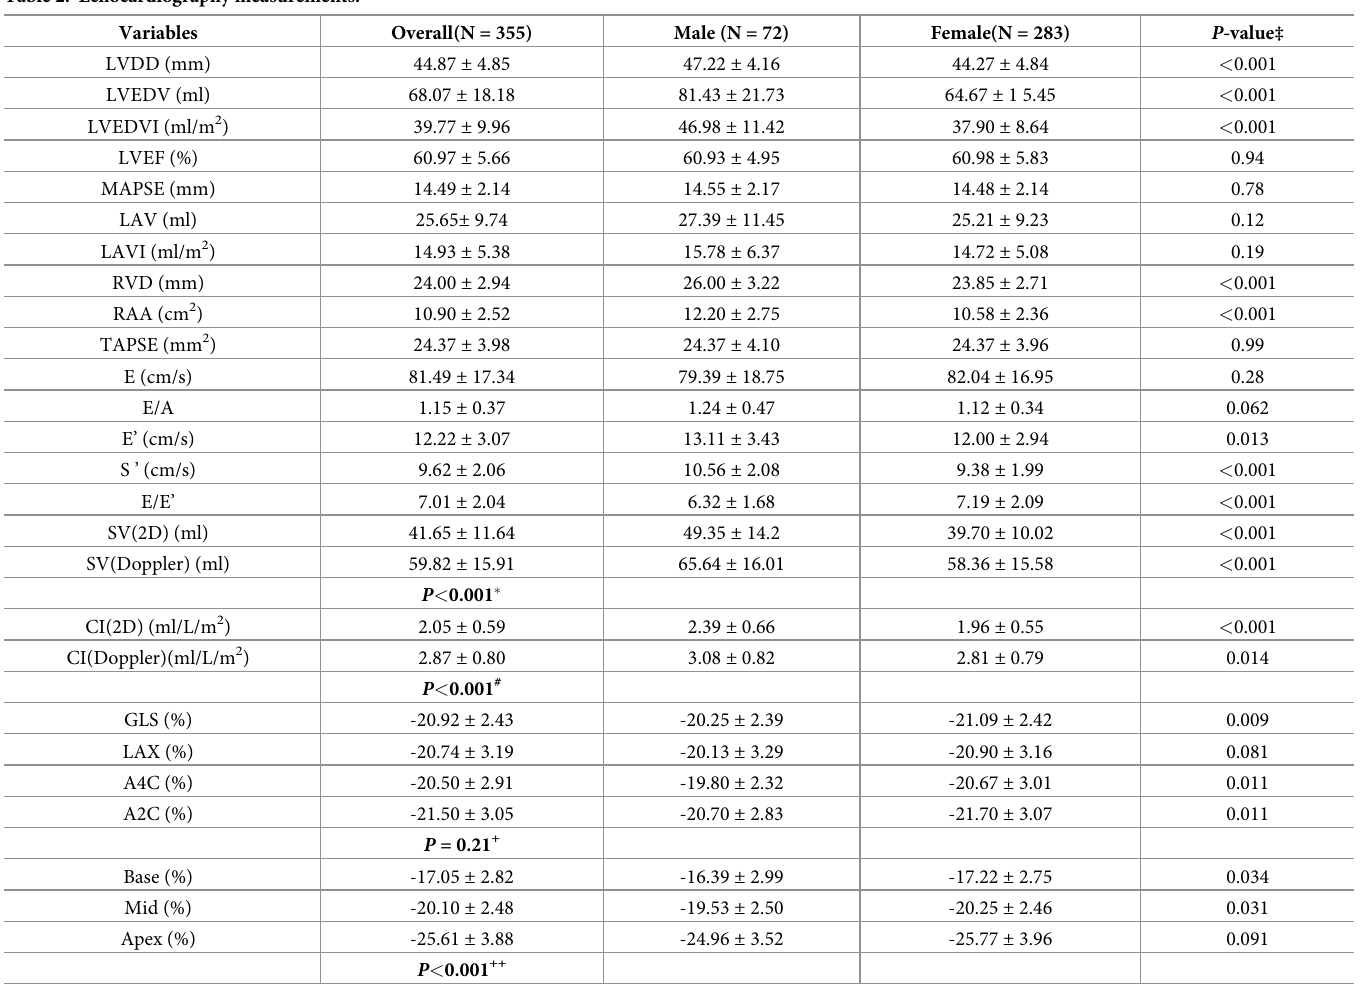
Table 2. Echocardiography